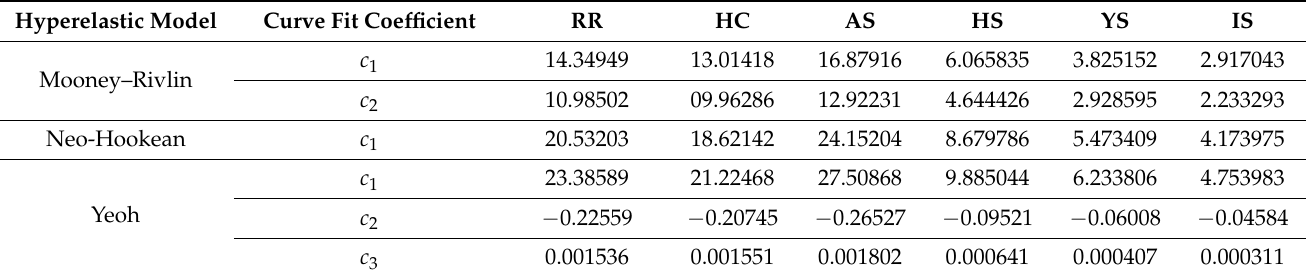
Table 2. Hyperelastic curve fit